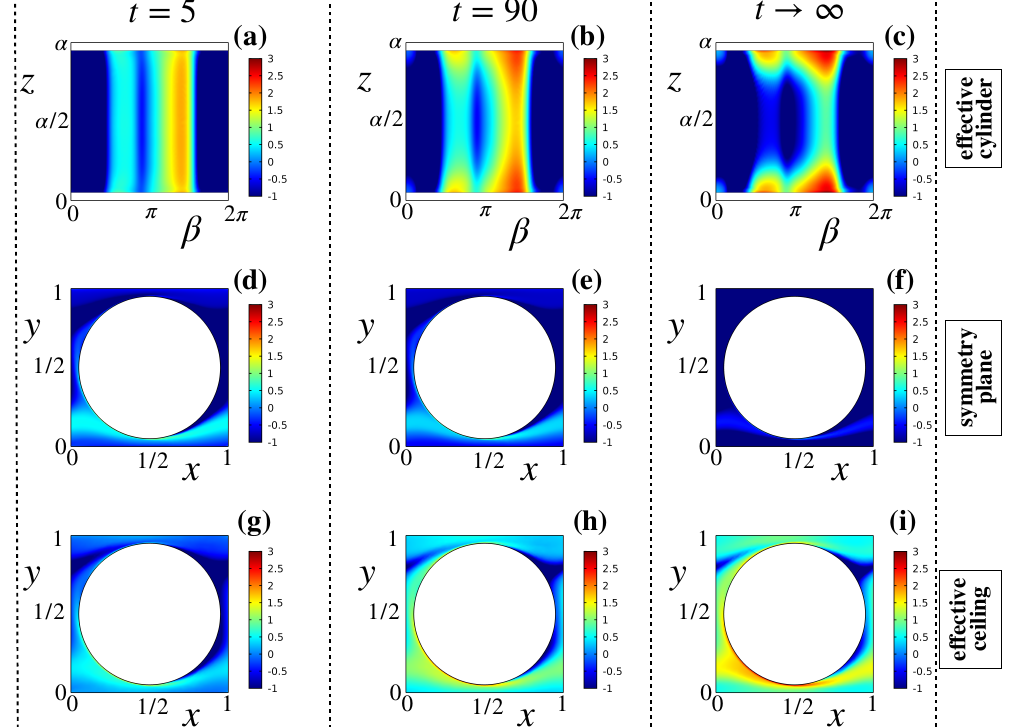
Figure 11. Transient behavior of the cumulative particle number density C ( x , t ) starting from an initial condition C ( x , t = 0 ) = 1 for tan − 1 θ l = 1/10 and for dimensionless particle radius and obstacle diameter equal to r p = 0.05, d o = 0.8, respectively. Because of the large interval of variation attained C is depicted in place of C for visualization purposed. by the cumulative particle concentration, log 10 The value of the particle Péclet number was fixed at Pe = 2800. Columns from left to right represent the concentration fields at dimensionless time t = 5, t = 90 and the steady-state field t → ∞ , respectively. Rows from top to bottom the unfolded effective obstacle surface, the symmetry plane z = α /2 and the ceiling of the effective transport domain, z = α − r p